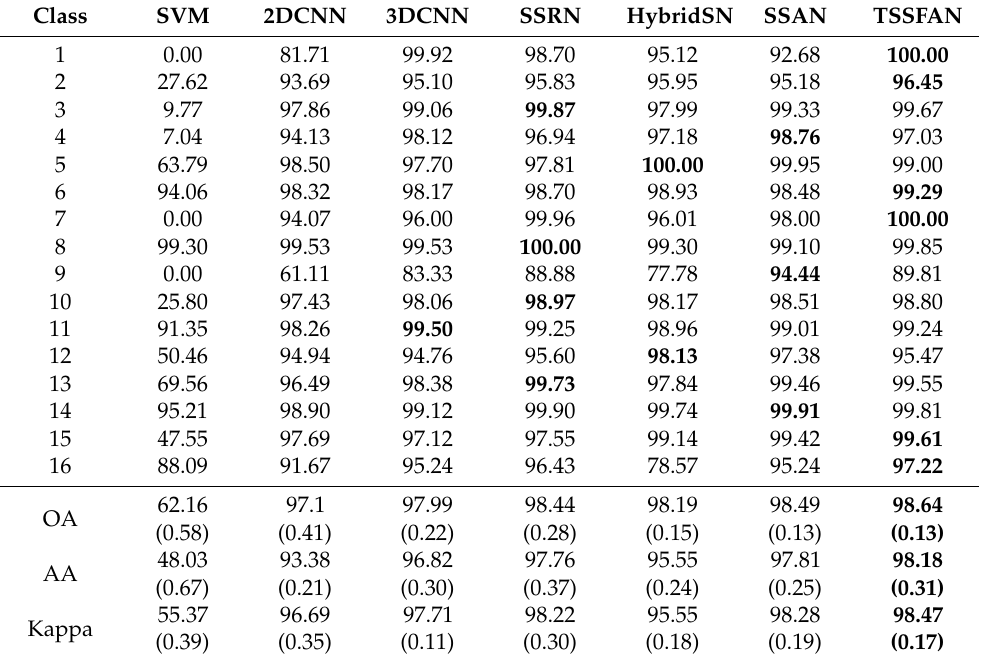
Table 5. Classification results of each method in Indian Pines (The bold format represents the best result).